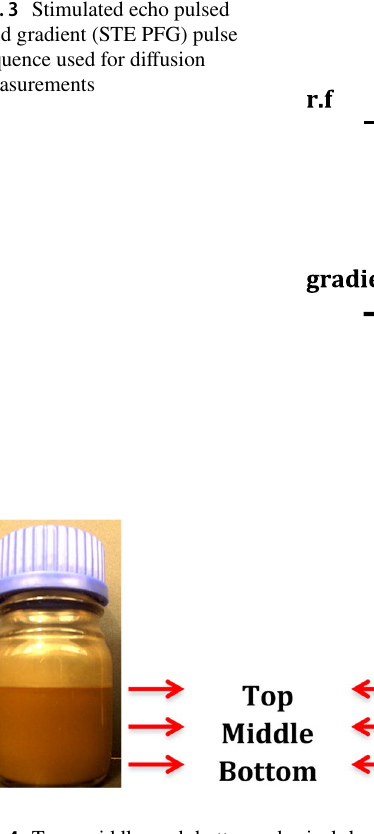
Fig. 4 Top, middle and bottom physical locations where samples were taken for diffusion measurements and hence droplet sizing using NMR. An oil layer is observed to form for the emulsion of the